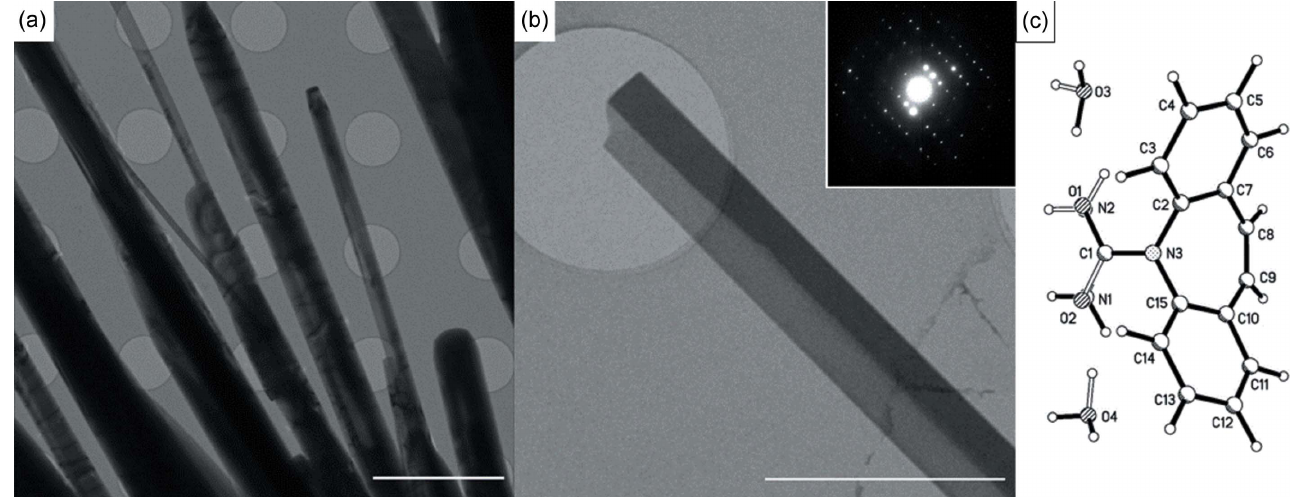
Figure 1 ( a ) Low-magnification image of CBZDH crystallized after 3 min on the TEM grid at 100 K showing an elongated morphology. Scale bar = 5 m m.